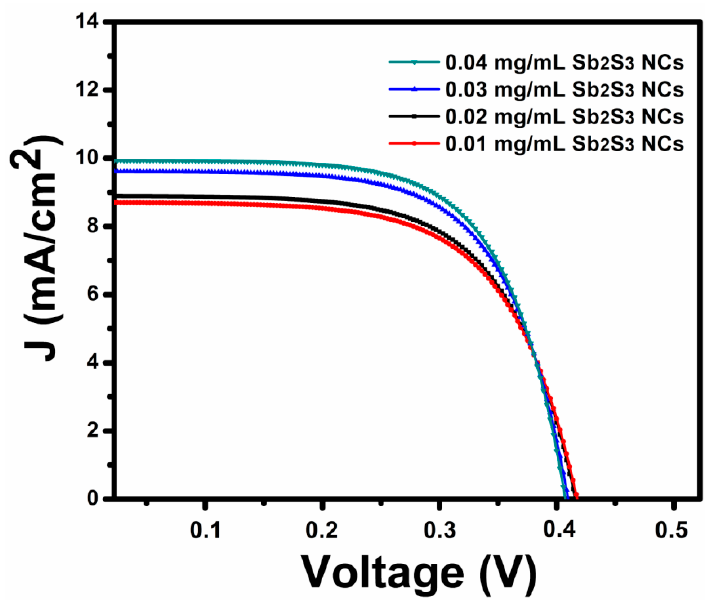
12 of 15 Table 1. Detailed photovoltaic parameters of the organic solar cell device under AM 1.5 sun illu- mination with light power intensity of 100 mW/cm 2 .